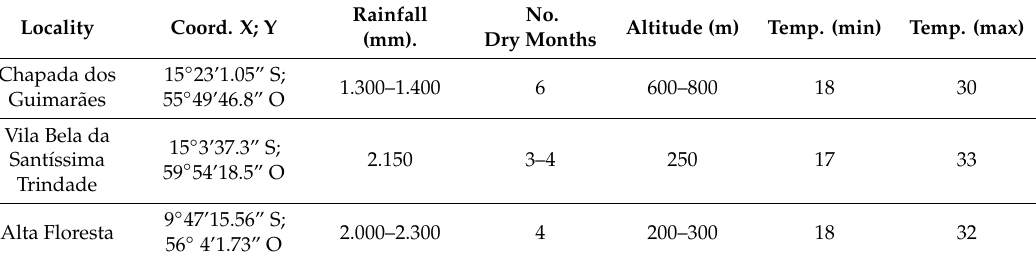
Table 3. Climatic indices of Mauritia flexuosa L.f. sites collected.